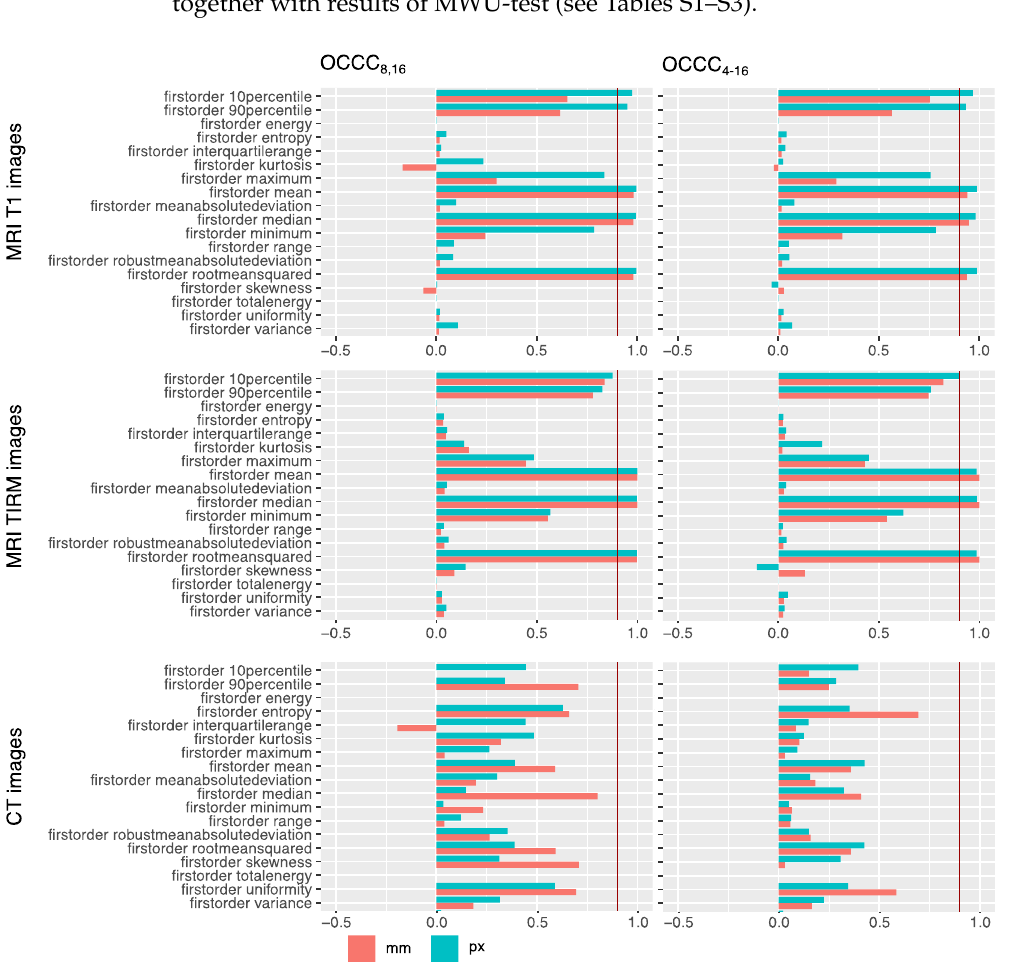
Figure 4. OCCCs 8,16 and OCCCs 4–16 for ROIs drawn in millimeters ( red ) and pixels ( green ). Excellent agreement of 0.9 is marked with a red line. Second- and higher-order features as well as numerical values can be found in the Supplementary Materials (Figures S1–S3, Tables S1–S3). Mean, median, and root mean squared concordantly showed excellent agreement across ROI sizes for MR images. None of the features showed excellent agreement for CT images; here, the best agreement of 0.8 is shown by the feature median for the millimeter sized ROI OCCCs 8,16 .